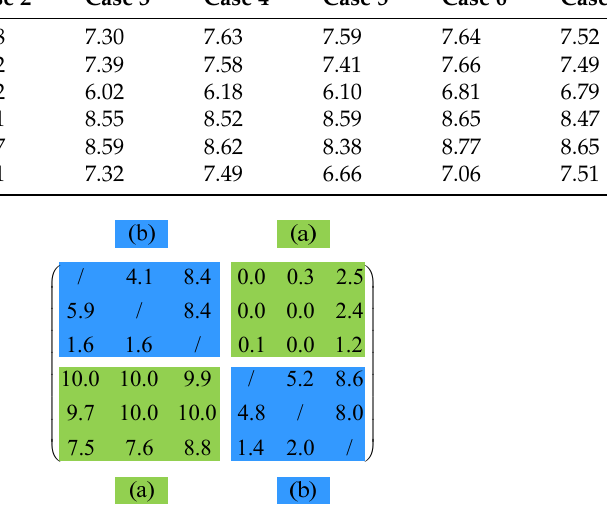
Figure 4. The mean of the data in Table 4. Table 5. The calculation results of S (Order of magnitude 2 10 × ).